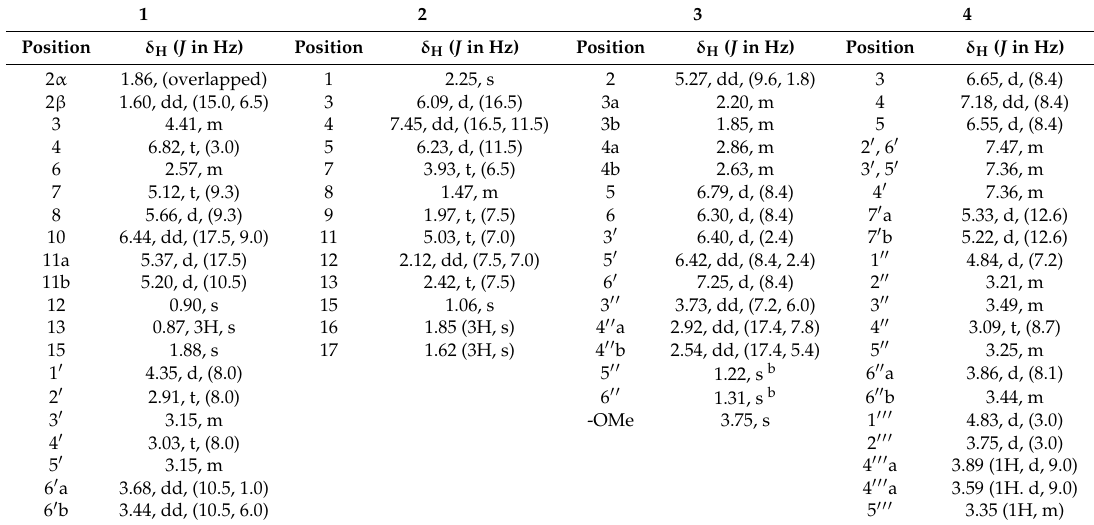
Table 1. 1 H-NMR Spectroscopic Data of Compounds 1 − 4 a .